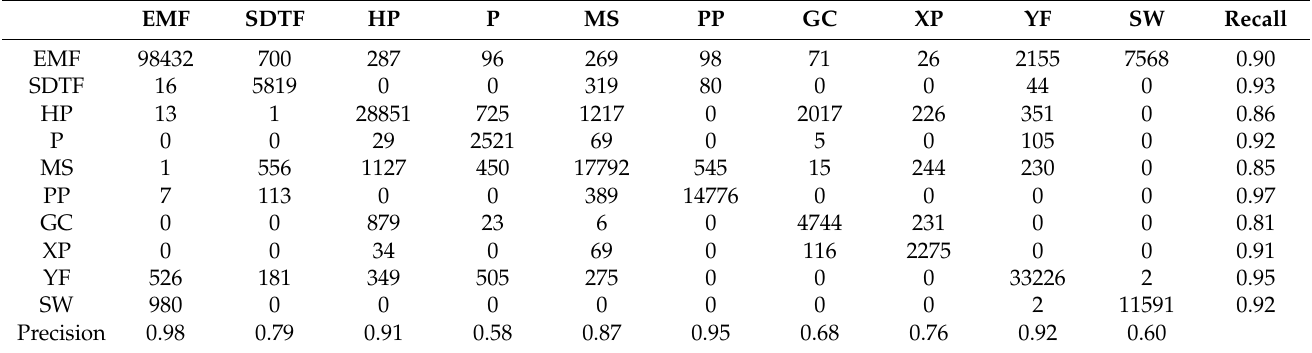
Table 3. Confusion matrix of biomes with RF (pixels) constructed with the test data (20% of the observed map). The rows represent the biomes of the present map, while the columns represent the biomes classified by RF. The number of correctly classified pixels is displayed on the